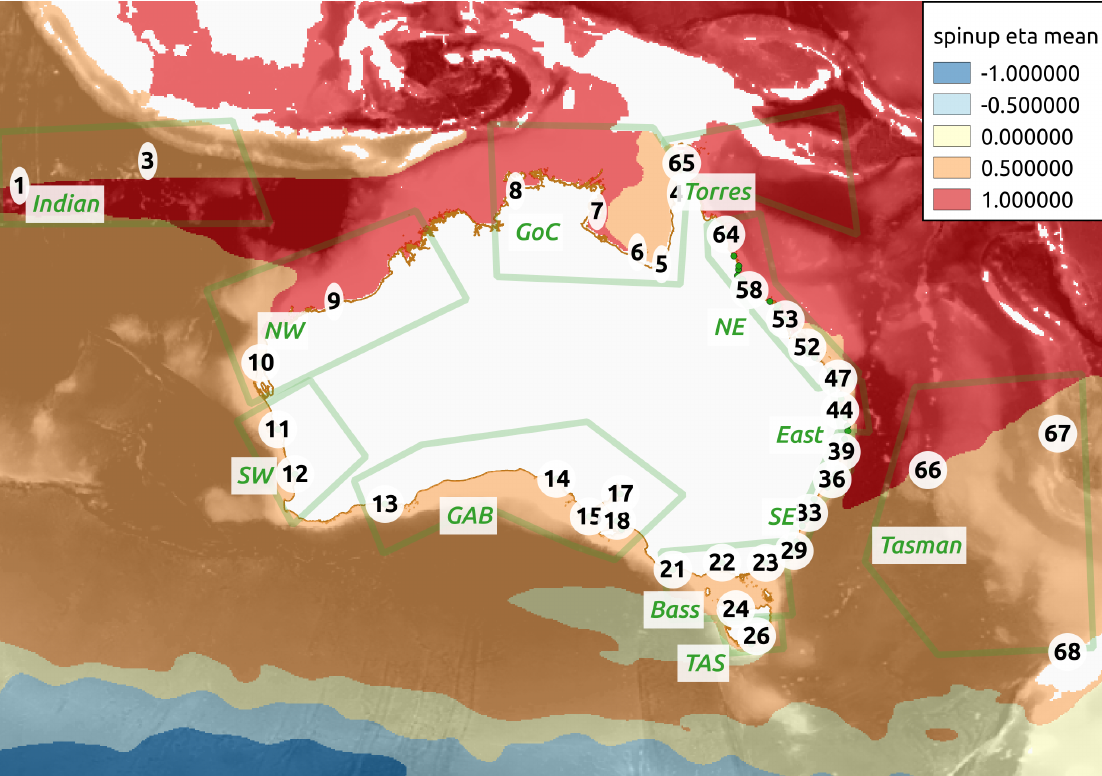
Figure 4. Geographic overview of Australia region. Ocean model bathymetry is indicated by grey background shading. Colour contours illustrate the ‘spin up’ model mean dynamic topography referenced below. Tide gauge locations are identified with sequential numbers with order chosen to loosely align with anti-cyclonic coastal wave propagation direction. Regional groupings are referenced in subsequent